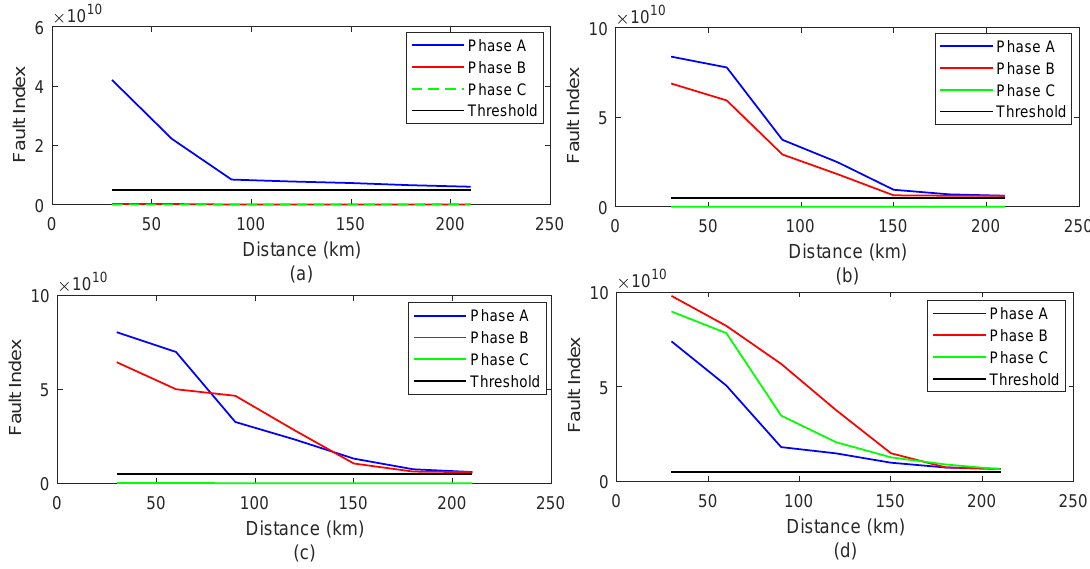
Figure 8. Effects of varying the fault location for detecting and classifying ( a ) L-G, ( b ) LL, ( c ) LL-G, and ( d ) LLL-G